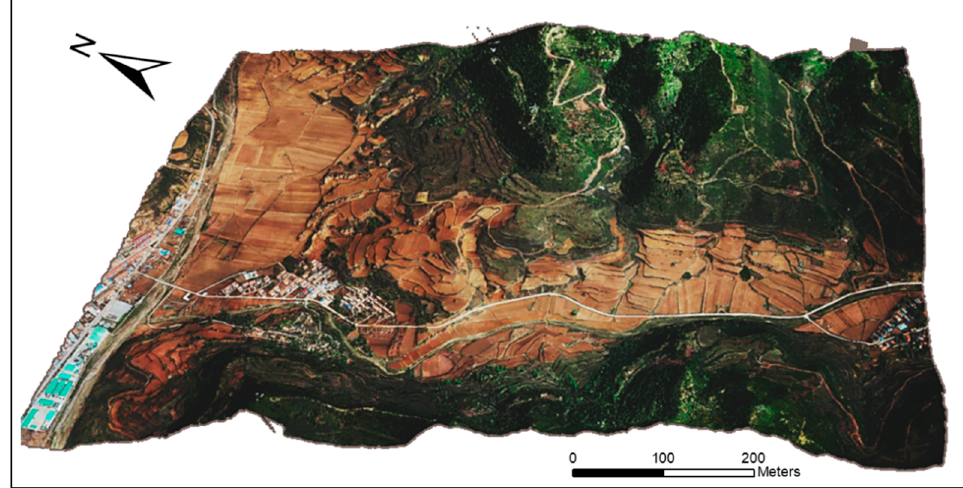
Figure 5. 3D UAV model of Shizhuang research area.